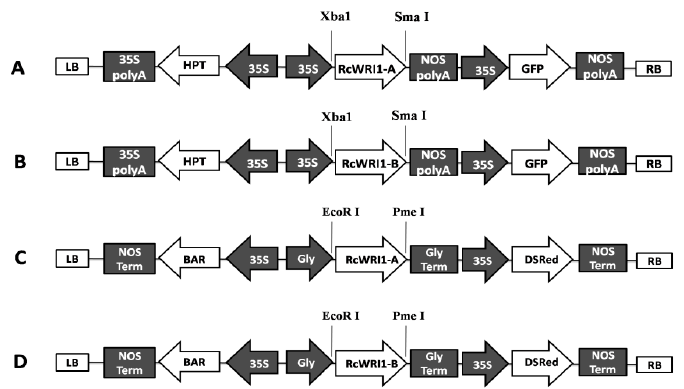
Figure 9. Schematic representation of RcWRI1-A , and RcWRI1-B expression constructs used for transient expression in Nicotiana benthamiana leaves and overexpression in the Arabidopsis wri1-1 mutant. ( A ) The RcWRI1-A expression cassette in pCAMBIA1303. ( B ) The RcWRI1-B expression cassette in pCAMBIA1303. ( C ) The RcWRI1-A expression cassette in pJC-Gly-DsRED. ( D ) The RcWRI1-B expression cassette in pJC-Gly-DsRED. 35S: CaMV 35S promoter. HPT: Hygromycin resistance gene. 35S polyA: 35S poly (A) signal sequence. Nos polyA: Nopaline synthase poly (A) signal sequence. Gly: Gly-promoter. BAR: Herbicide resistance bar gene. Gly term: Gly terminator. NOS term: Nopaline synthase terminator. GFP: Green fluorescent protein. RB: Right border. LR: Left border. DSRed: Discosoma red fluorescent protein.